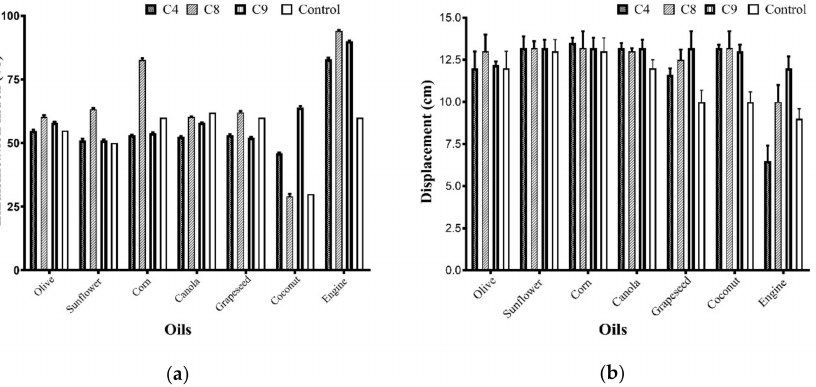
Figure 3. Emulsification index E24 ( a ) and oil displacement ( b ) produced by the cell-free supernatants (CFS) of the bacterial strains in BH medium with olive oil, against different oils. Data are given as the mean ± SD ( n =